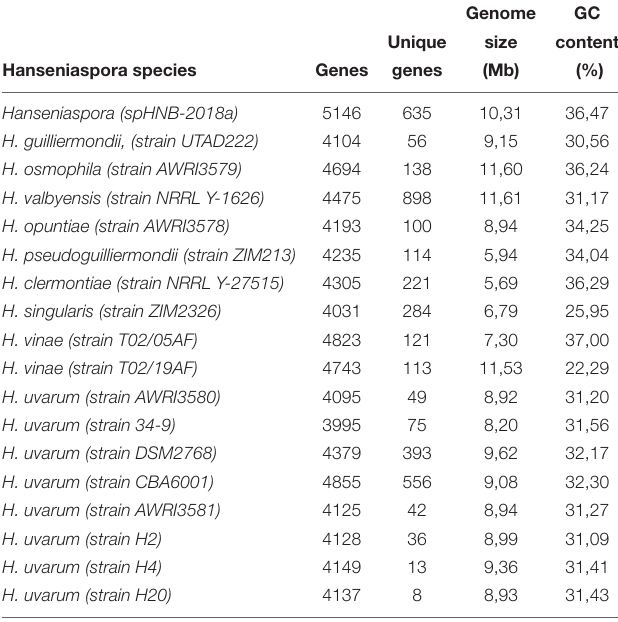
TABLE 4 | Summary of comparative genomic analysis of Hanseniaspora and H. uvarum strains.